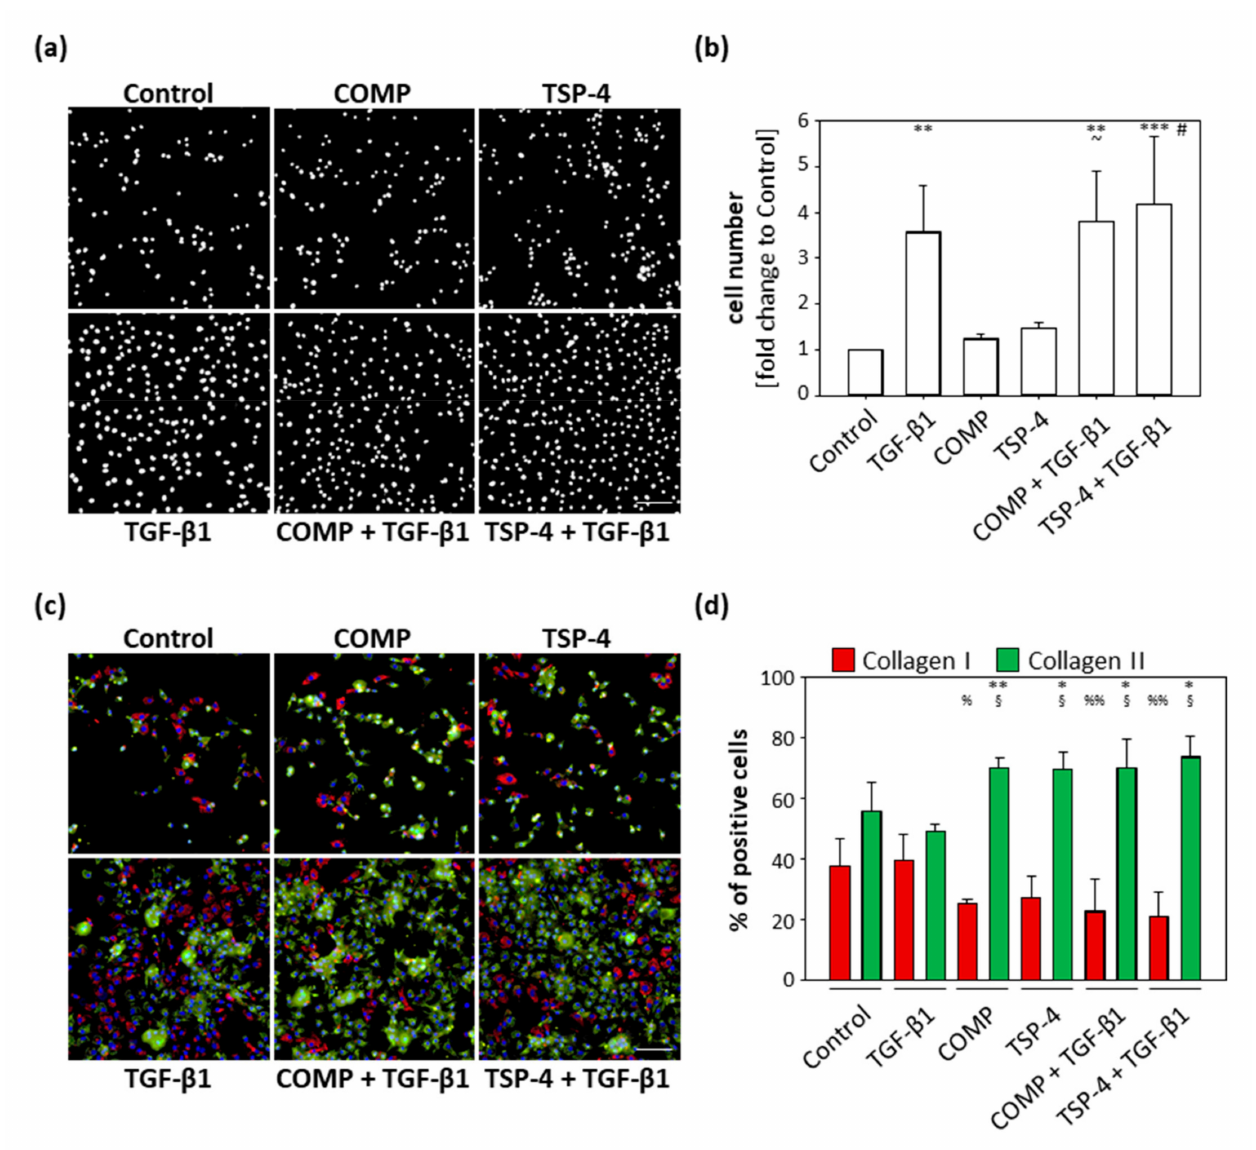
Figure 4. Effect of COMP and TSP-4 on chondrocyte proliferation and dedifferentiation. Chondrocytes were stimulated with COMP (10 µ g/mL) or TSP-4 (10 µ g/mL) for seven days. ( a ) Nuclei were DAPI stained at day 10. ( b ) The fold changes of the counted nuclei are represented and each bar shows the mean + SD. The significant differences between the control and all other conditions were calculated. Differences between COMP, TGF- β 1 and COMP + TGF- β 1 as well as TSP-4, TGF- β 1 and TSP-4 + TGF- β 1 were calculated. Differences to the control are indicated by an asterisk *, to COMP by waves ~ and to TSP-4 by rhombus #, as well as significance indicated by p ≤ 0.05 #~; p ≤ 0.01 **; p ≤ 0.001 ***. ( c ) Immunofluorescence staining of collagen I (red), collagen II (green) and nuclei (blue) at day 10. ( d ) Percentages of chondrocytes expressing collagen I and II are represented and each bar shows the mean + SD. The significant difference between collagen I and collagen II positive cells was calculated and significance indicated as p ≤ 0.05 *; p ≤ 0.01 **. Differences of collagen I and collagen II positive cells to the control were calculated and significance indicated as p ≤ 0.05 % or §; p ≤ 0.01 %%, respectively. TGF- β 1 (0.5 ng/mL) served as an inducer of proliferation and collagen synthesis and unstimulated cells as a control. ( n = 3); scale bar = 100 µ